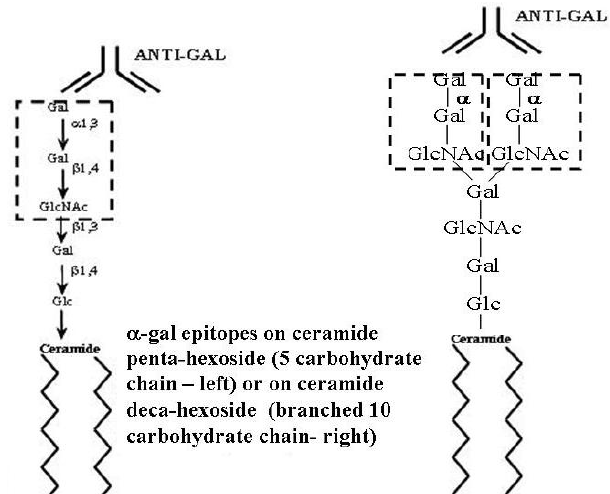
glycolipid with 10 carbohydrate branched chain.  -gal